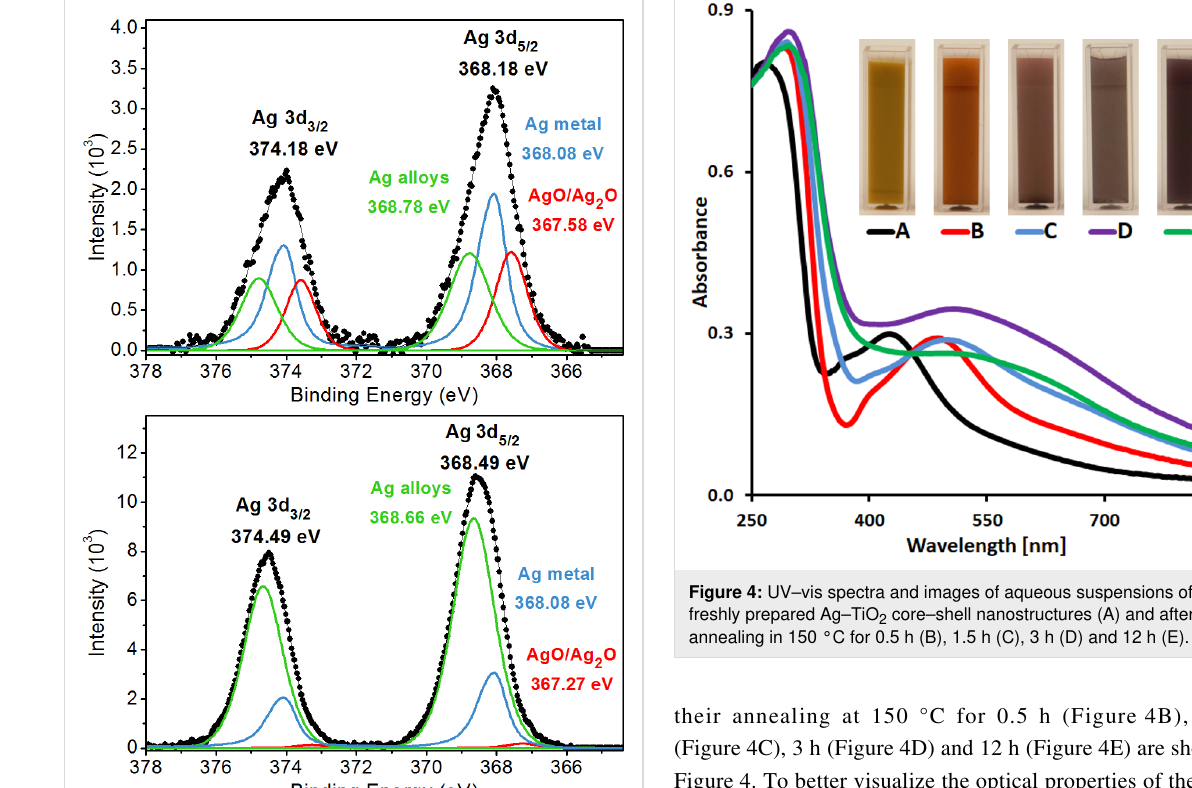
their annealing at 150 °C for 0.5 h (Figure 4B), 1.5 h (Figure 4C), 3 h (Figure 4D) and 12 h (Figure 4E) are shown in Figure 4. To better visualize the optical properties of the